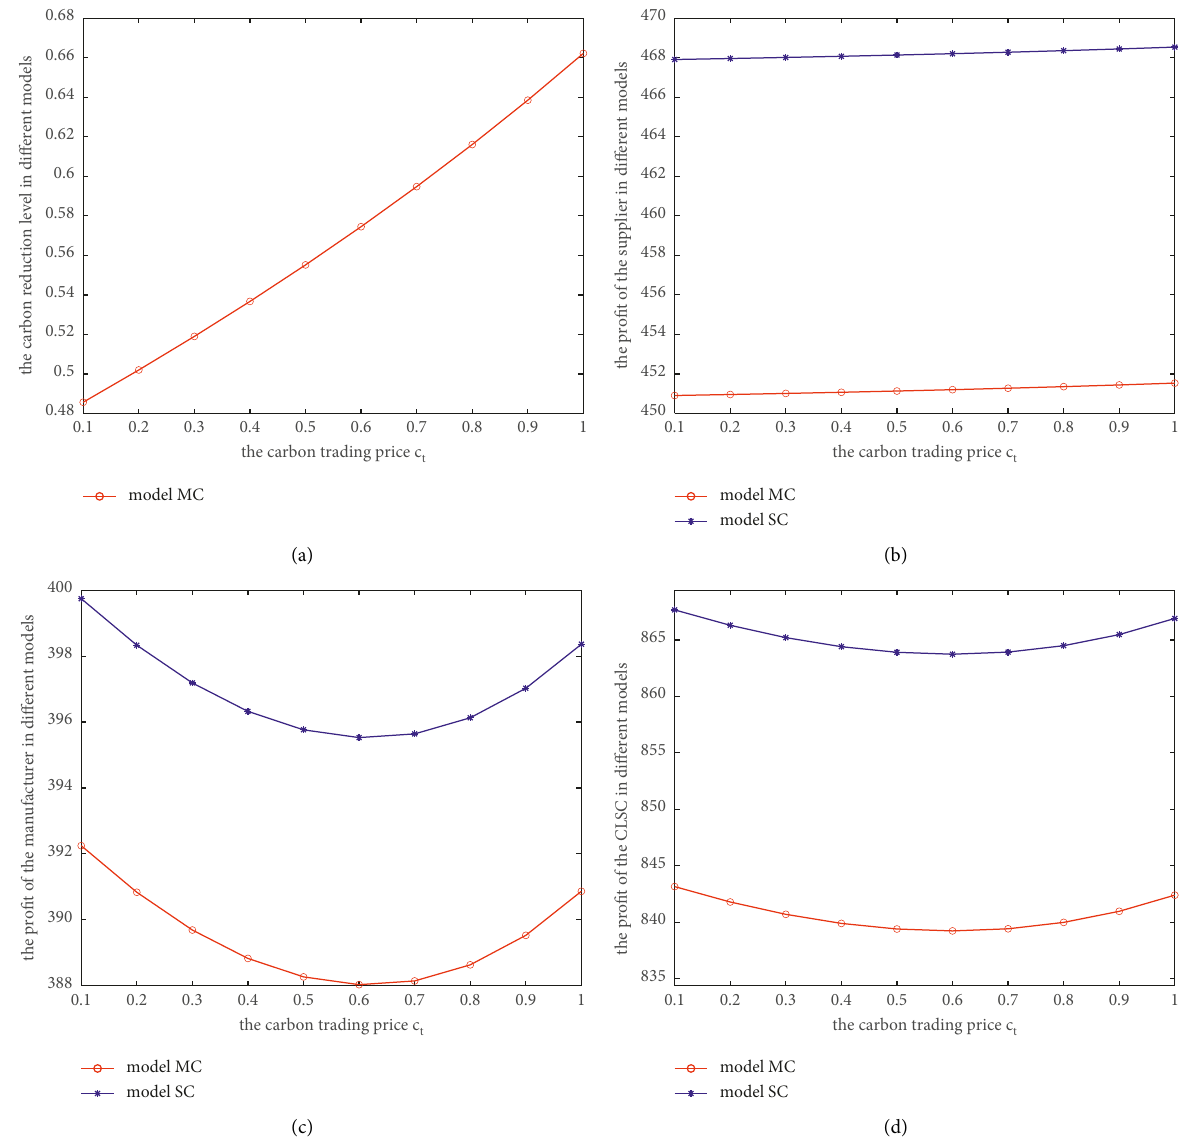
Figure 6: The carbon trading price c t . (a) The capacity investment of manufacturing in different models. (b) The profit of the supplier in different models. (c) The profit of the manufacturer in different models. (d) The profit of the CLSC in different